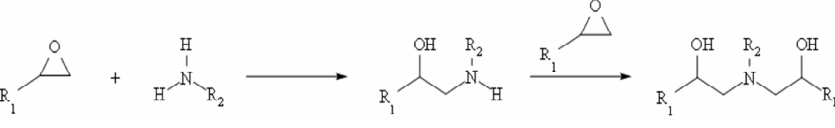
Figure 1. Reaction of a primary amine with an epoxy compound.